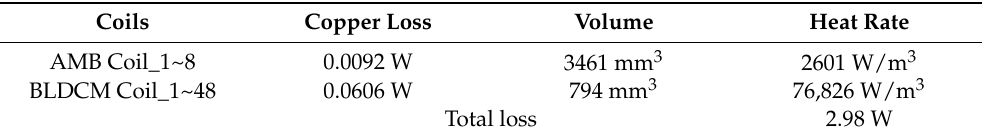
Table 9. Heat rate of the copper losses in the MLRW.